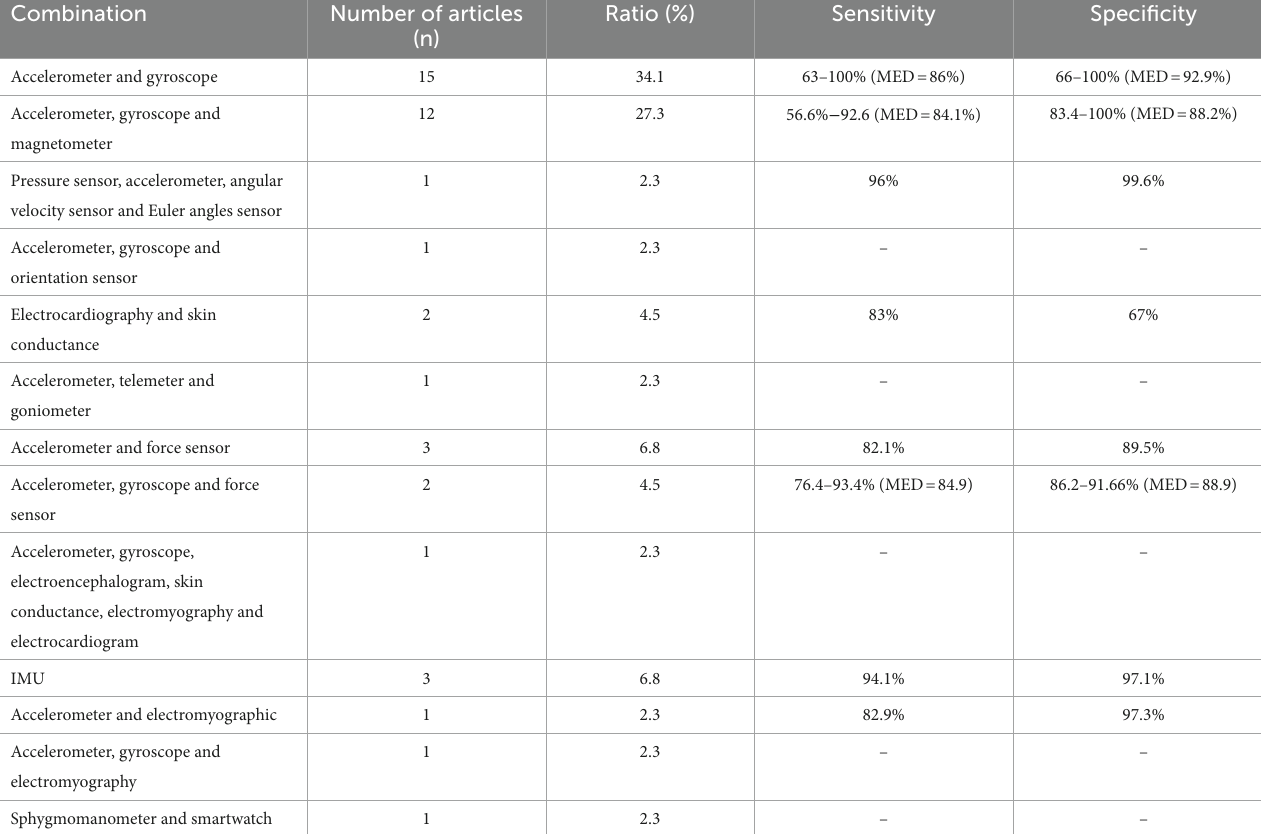
TABLE 4 Number of publications per type of outcome for each sensor combination. Combination Number of articles